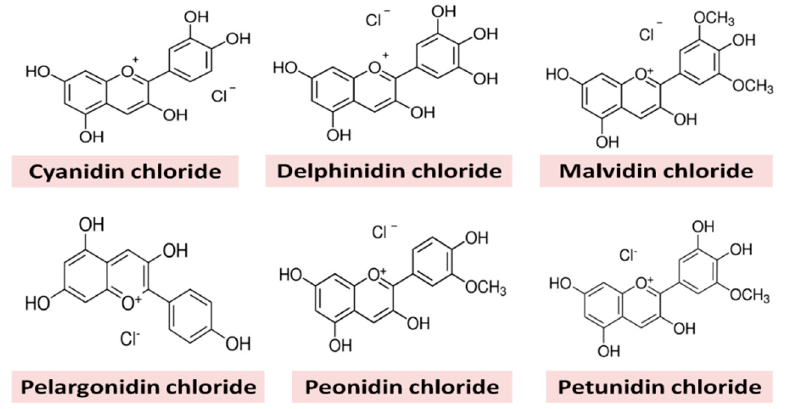
Figure 1. Structures of different anthocyanins present in wheat .